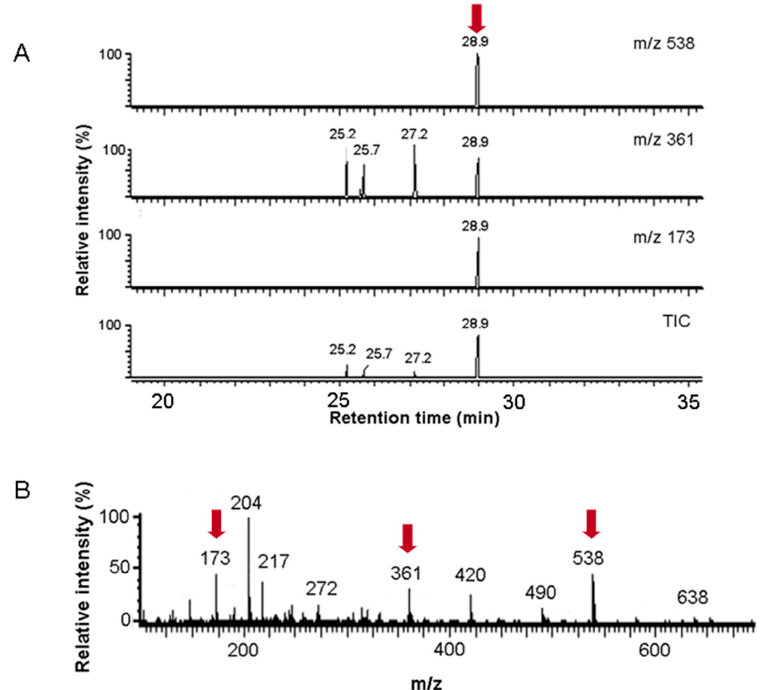
Figure 2. Gal-1-P and F-Gal-1-P conversion by GALT. ( A ) Total ion current (TIC) and mass selective chromatograms of trimethylsilytated oligosaccharides. The products of the GALT reaction, UDP-conjugates of either Gal or F-Gal, were indirectly detected in a coupled reaction catalyzed by recombinant human β 4-galactosyltransferase converting the substrate GlcNAc into the corresponding disaccharides. The formation of products was monitored after enrichment / desalting on graphitized carbon and trimethylsilylation by gas chromatography-mass spectrometry (GCMS). Gal-GlcNAc was identified at 28.9 min (marked by red arrow) based on an authentic standard and on the electron-impact (EI) fragment spectrum (Figure 2B). F-Gal-GlcNAc at slightly decreased retention times and giving rise to alternative fragment series with incremental mass decrease of -70 amu was not detectable. ( B ) EI mass spectrum of the product at 28.9 min. The EI spectrum shows intense fragment ions (marked by red arrows) at m / z 173, 361, and 538, which characterize the trimethylsilylated disaccharide Gal1-4GlcNAc.